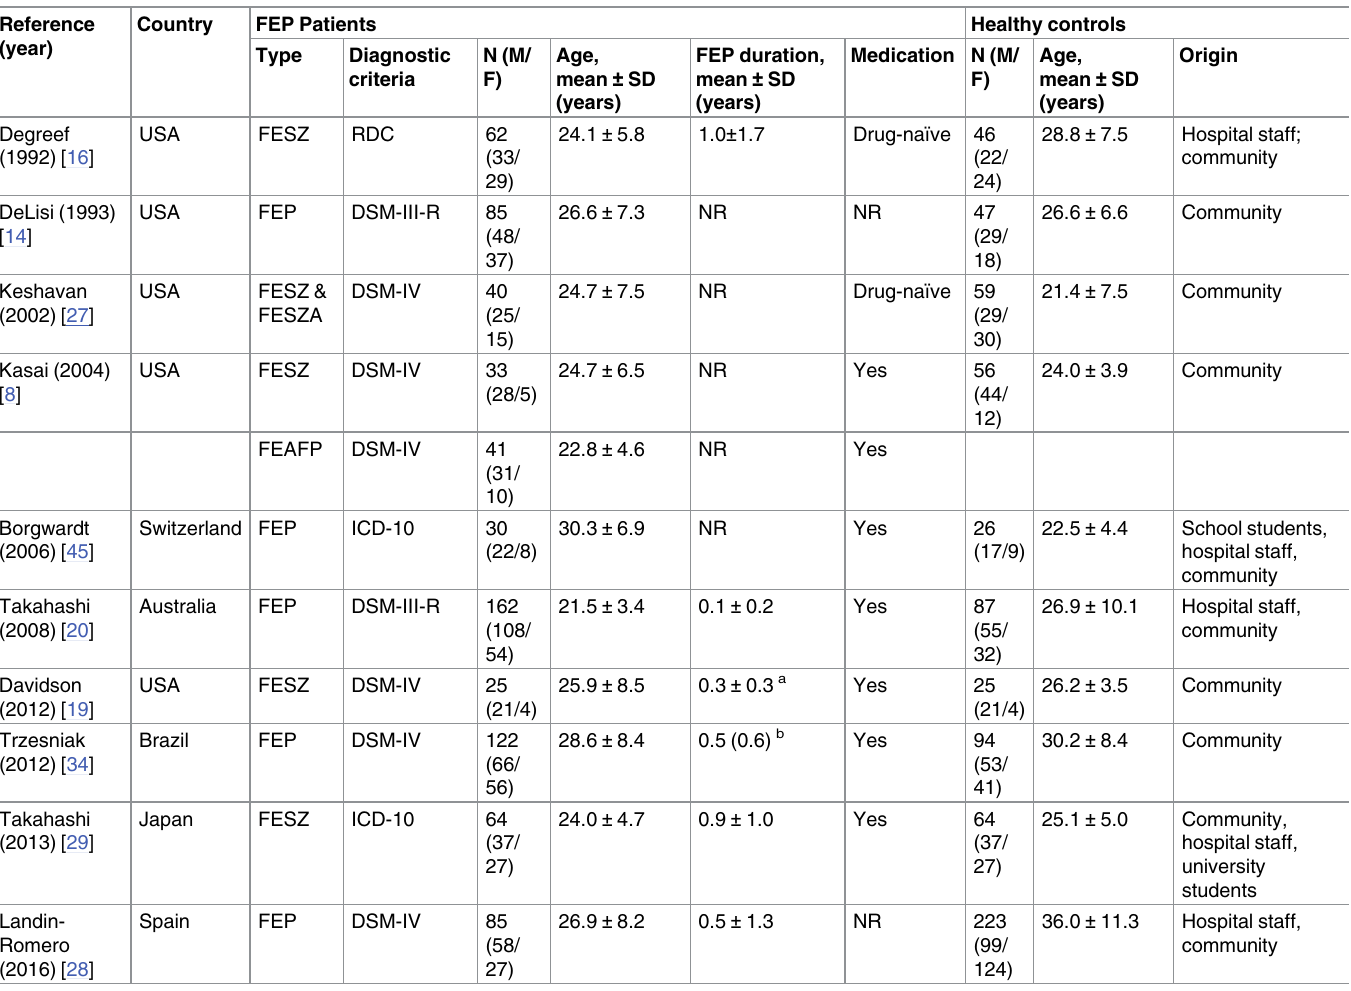
Table 1. Sample characteristics of the cross-sectional